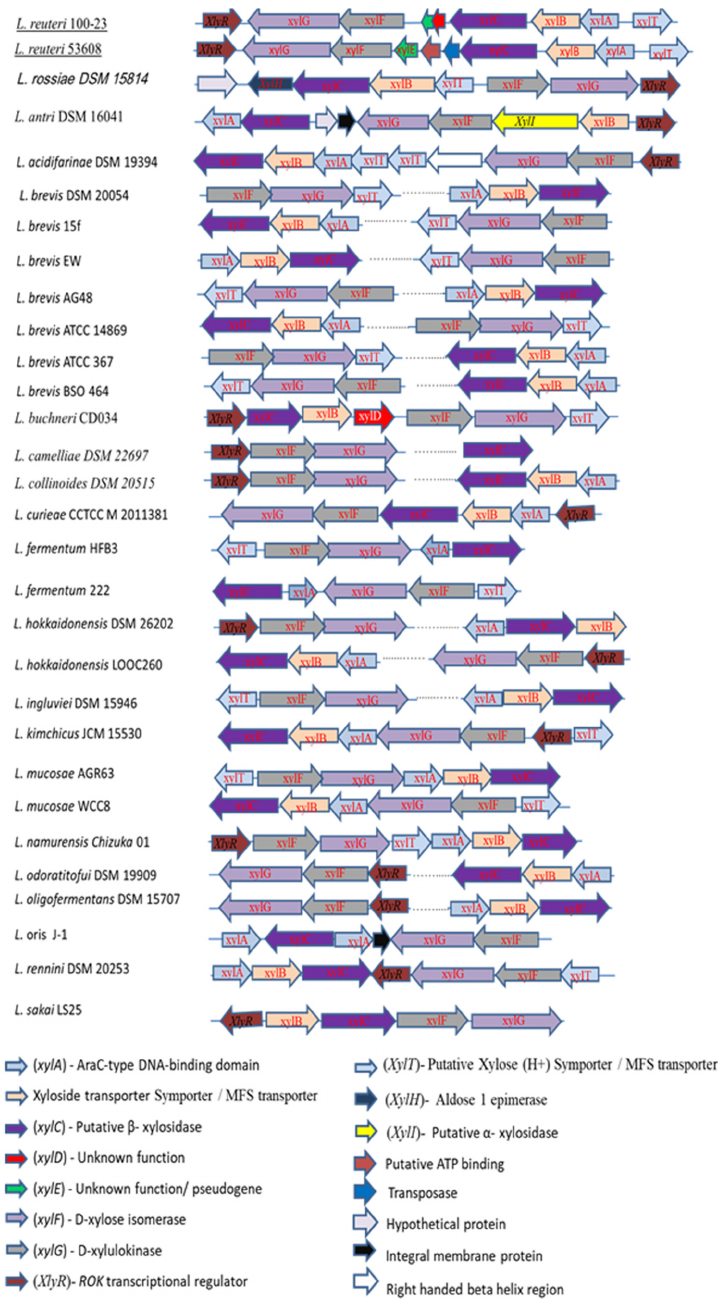
Figure 9. Synteny analysis of putative XOS-utilising gene organisation in Lactobacilli species.